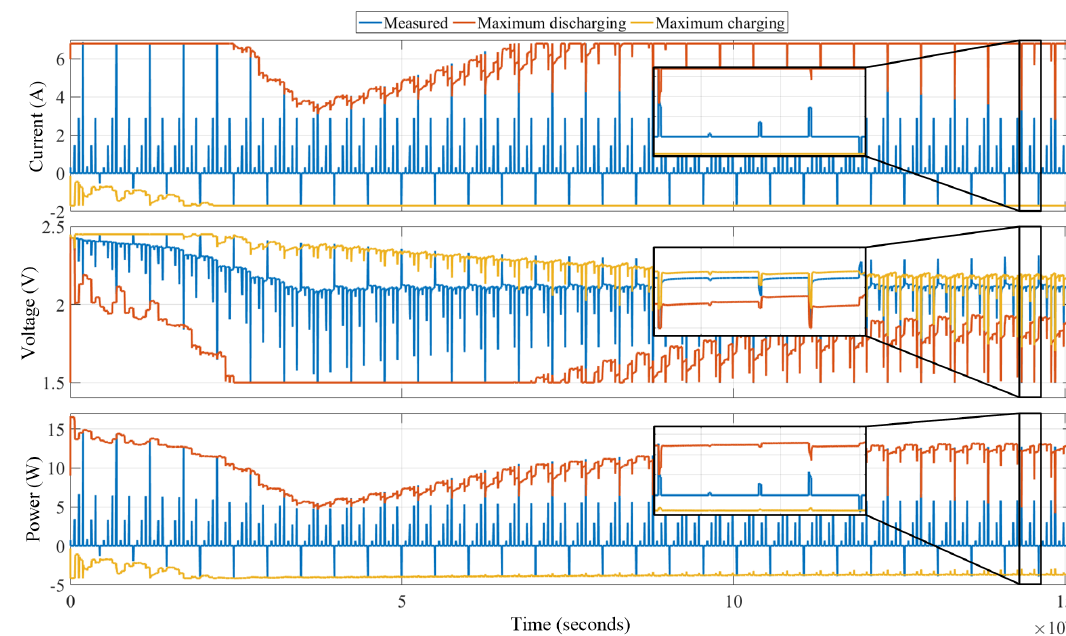
Figure 8. The mixed pulse profile for maximum available power estimation and the instantaneous maximum available power at one second.